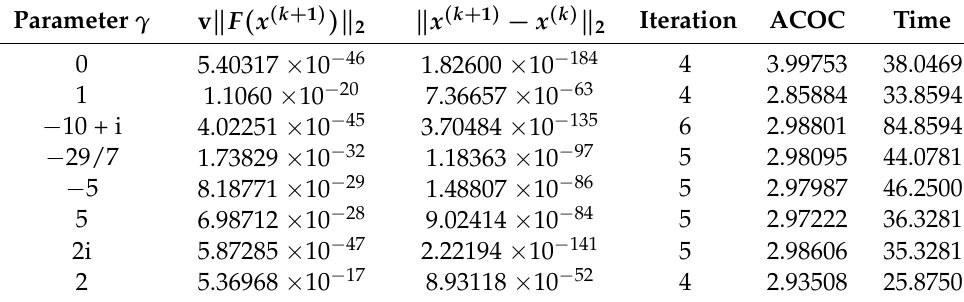
Table 2. Hammerstein results for different